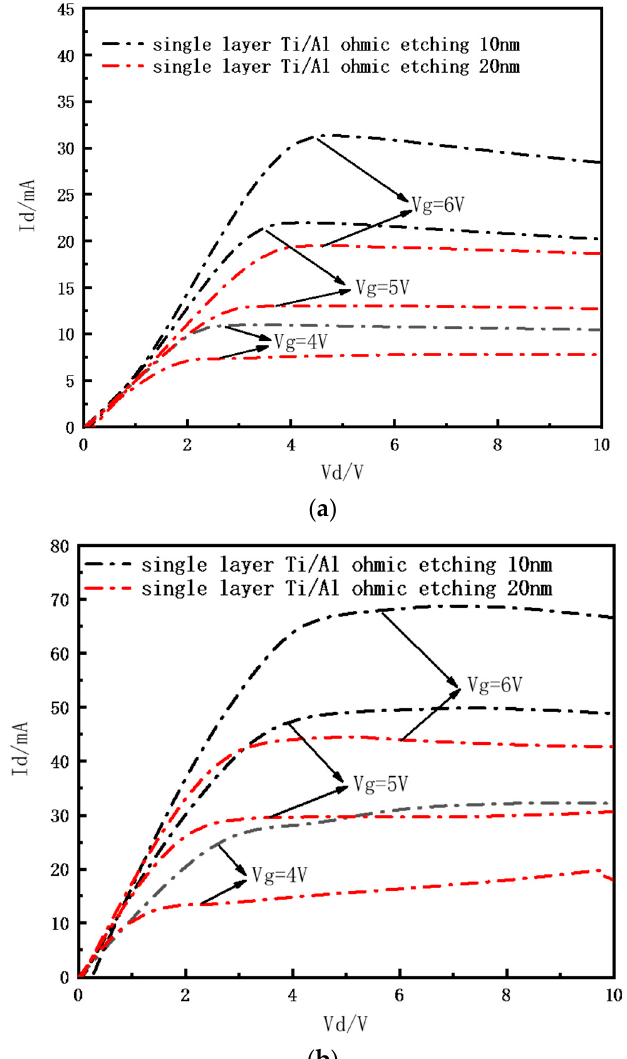
Figure 6. ( a ) Output characteristic curve of conventional structure single-layer electrode HEMT device with 10/20 nm etching depth. ( b ) Output characteristic curve of ring-gate single-layer electrode HEMT device with 10/20 nm etching depth.